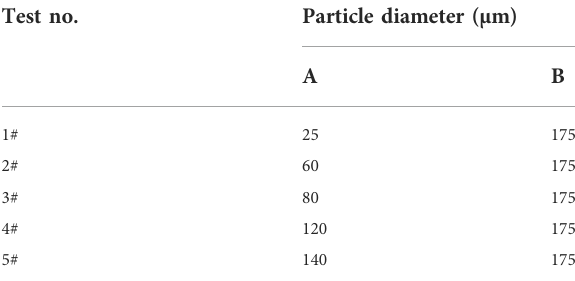
TABLE 3 The plate position arrangement of double-layer plates. Test